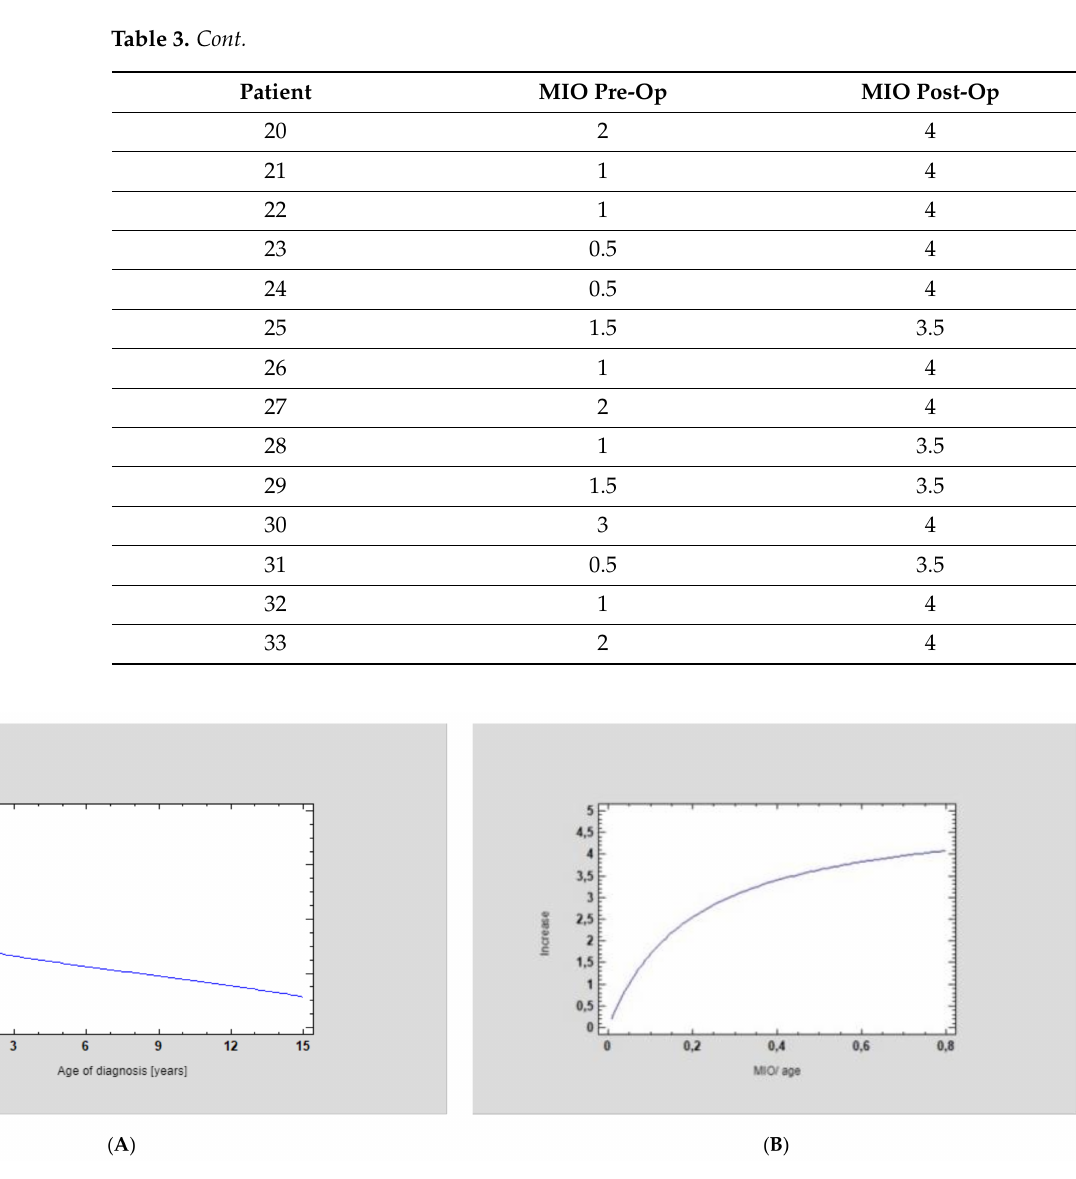
Figure 9. Statistical analysis of A—ANOVA for MIO/age factor, showing a significant increase in mouth opening in the cohorts who underwent the accurate surgical procedure and the strong relationship between the two factors: ( A ) initial MIO at the age of diagnosis and ( B ) correlation of MIO increase after surgery according to the age of the patient ( p < 0.0001, correlation coefficient = 0.69, R-squared = 46.96%). The older the patient, the better the MIO improvement that was observed. This is due to the fact that older patients can open their mouths wider than young individuals. Complications were rare (Table 4). Three individuals developed re-ankylosis, and one associated infection that necessitated TMJ removal and